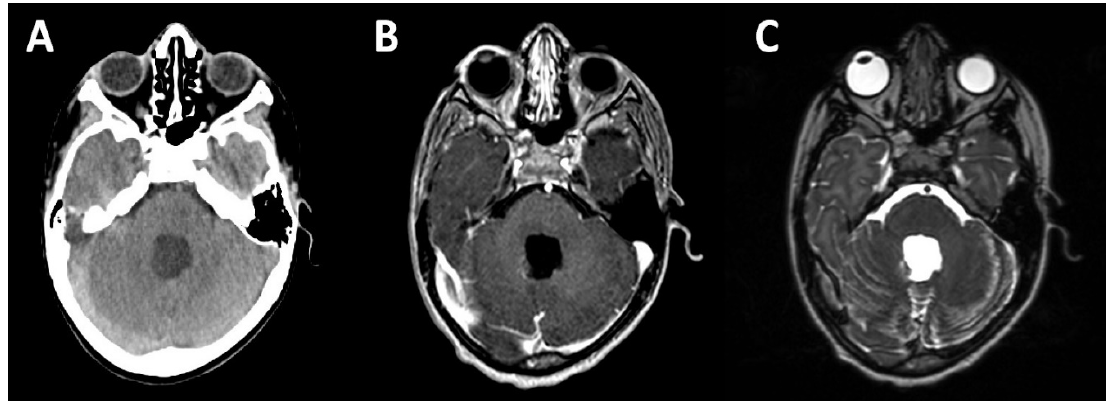
Figure 1. CT and MRI simulation. Axial images from CT ( A ) and MRI ( B , C ) simulation for radiation treatment planning purposes. This patient is an 8-year-old male who presents for adjuvant radiotherapy three weeks following gross total resection of average-risk posterior fossa medulloblastoma. CT simulator axial image showing the resection cavity is shown in ( A) ; ( B , C ) show MRI simulator axial images from the same plane; T1 post-gadolinium contrast sequence is shown in ( B ), and the T2 sequence is shown in ( C ). The MRI simulator allows for identical positioning and immobilization to be achieved, facilitating fusion of CT and MRI images as demonstrated here.